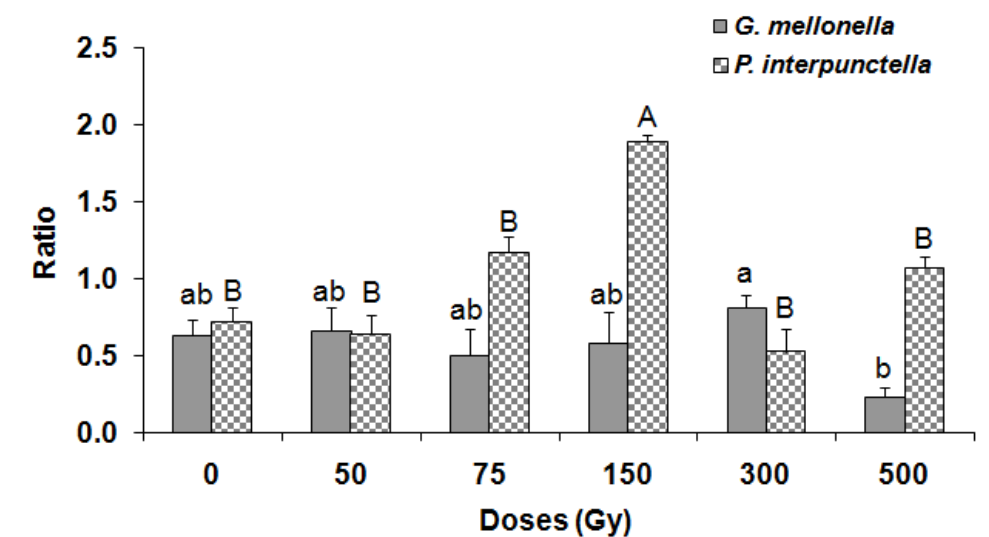
Figure 3. Percentage of adult emergence (% ± SE) of parasitoid H. hebetor developing from the irradiated larvae of G. mellonella and P. interpunctella.